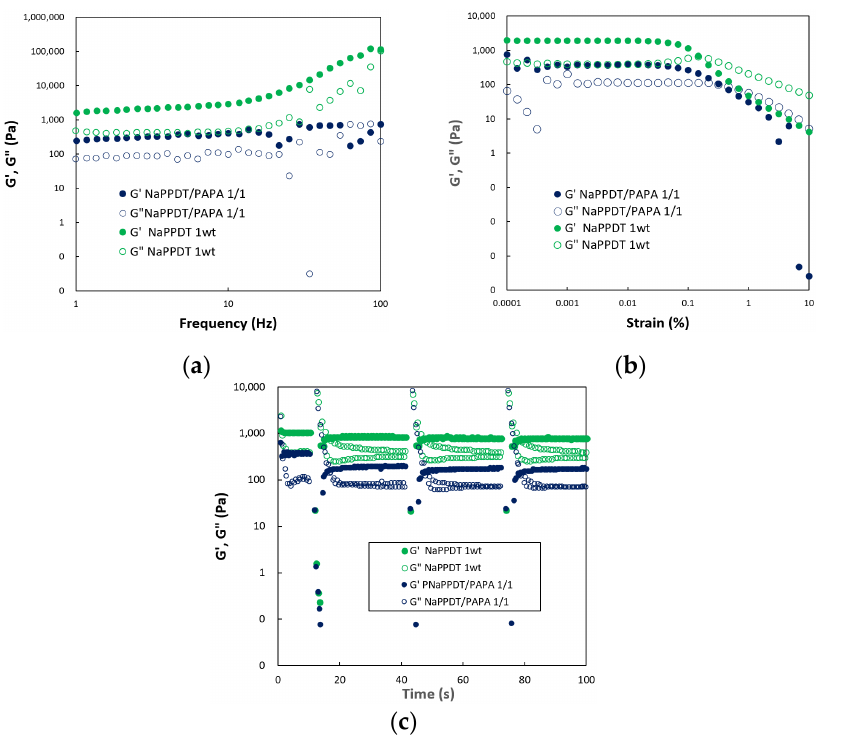
Figure 2. Rheometric results of NaPPDT / PAPA hydrogel systems: ( a ) frequency sweep, ( b ) strain sweep, and ( c ) periodic step-shear test (a vibration of G” was observed in both samples, probably due to the vibration of gels while the measurements were